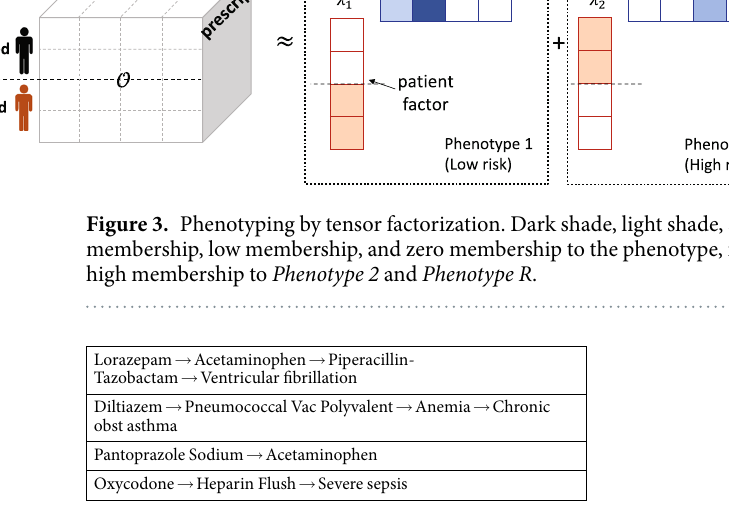
Table 1. Examples of time-ordered EHRs sequences. Each sequence consists of formulary drug codes (prescription) and ICD-9 codes (diagnosis), and is used in Word2Vec to derive pairwise